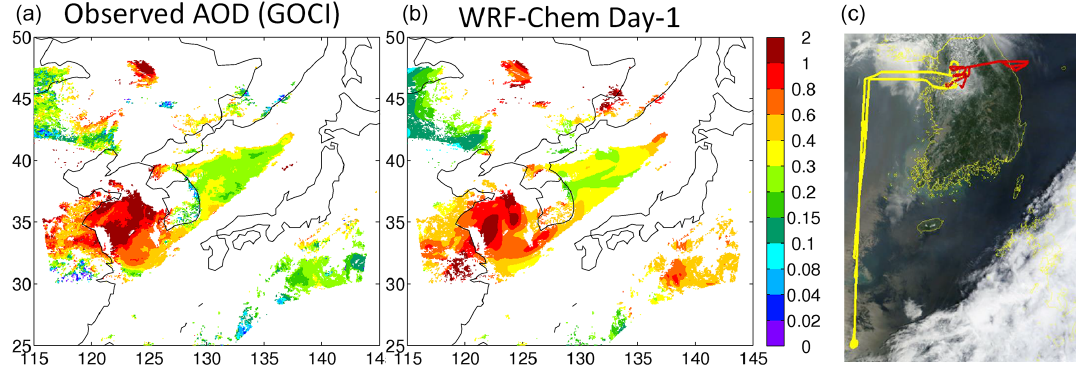
Figure 6. Observed (a) and forecasted (b) AOD maps at 03:00UTC (noon local Korean time) on 25 May. (c) Advanced Himawari Imager true color imagery for the same time with overlays of the DC-8 (in yellow) and Twin Otter (in red) flight tracks for that day (source: KORUS-AQ flight